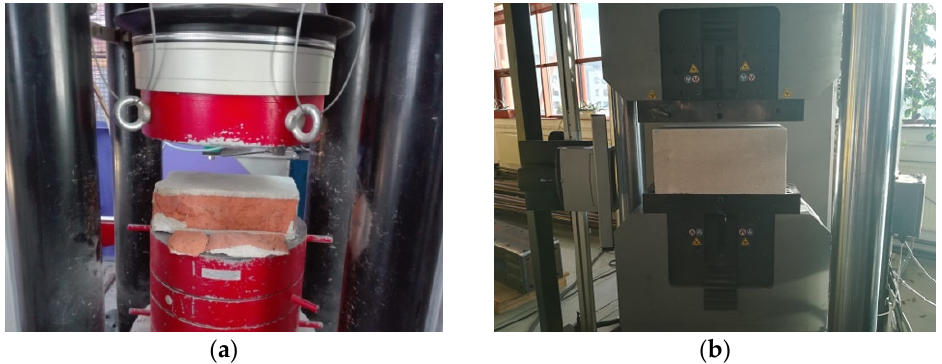
Figure 13. Strength tests of masonry units: ( a ) tests of solid bricks, ( b ) tests of autoclaved aerated